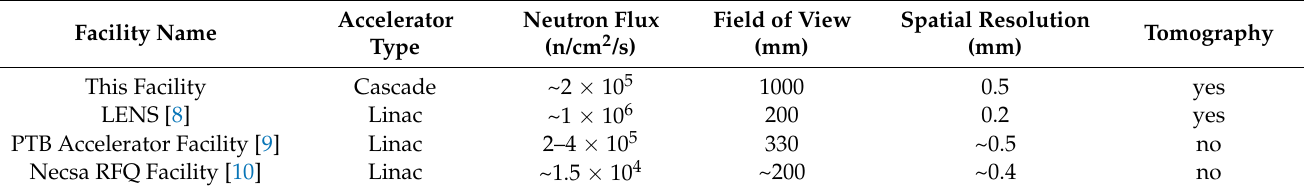
Table 1. The comparison between this system and other systems on characteristic parameters.